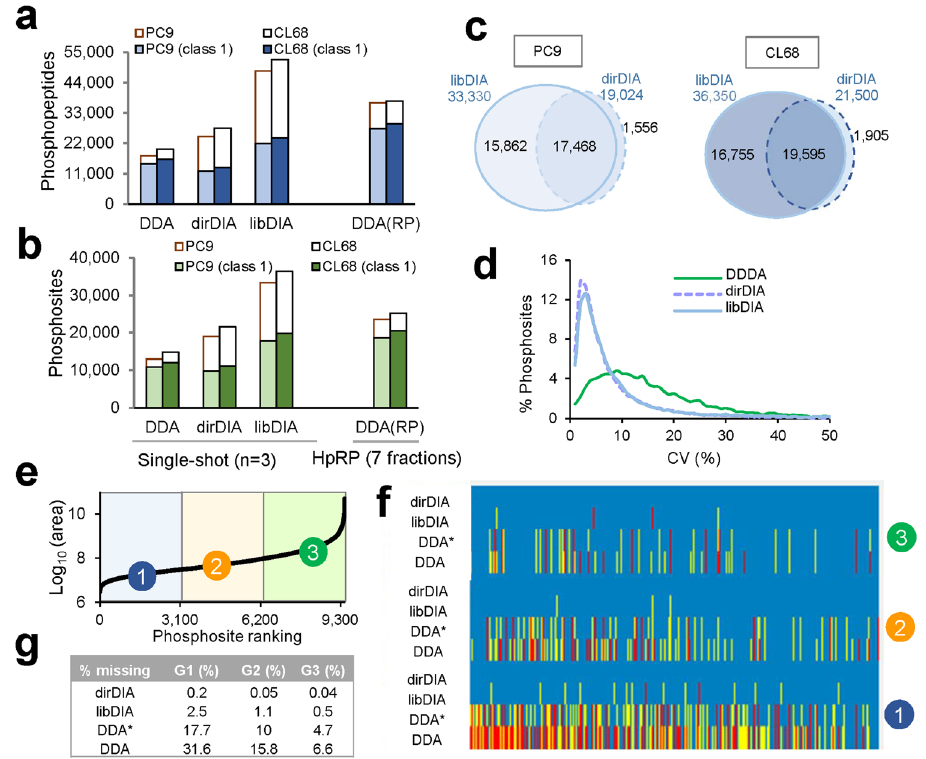
Fig. 4 Comparison of quanti fi cation performance in DDA and DIA using cell lysate. Two NSCLC cell lysate of PC9 and CL68 were processed by both DDA and DIA mode including reverse-phase (RP) fractionation. The DDA data were searched by MaxQuant, whereas DIA was analyzed by Spectronaut in both library-based and direct DIA mode. a Summary of phosphopeptides identi fi ed by single-shot DDA, StageTip fractionated DDA (7 fractions run in duplicate), library-based DIA (libDIA), and direct DIA (dirDIA). b Phosphosite identi fi cation comparison. The single-shot DDA and DIA were acquired in triplicate. c Overlap of phosphosites between dirDIA and libDIA. d Distribution coef fi cient of variation, CV% of phosphosites of PC9 cell ( n = 9,665 for DDA, 19,007 for dirDIA, and 30,260 for libDIA. A median coef fi cient of variation (CV) value of 13.0%, 4.3%, and 5.2% were obtained for DDA, dirDIA, and libDIA in PC9, respectively. e Distribution of phosphosite abundance rank of commonly quanti fi ed 9456 phosphosites in DDA, DDA match between runs (represented as DDA*), libDIA, and dirDIA. f Phosphosites identi fi cation per each abundance group across triplicate measurements. The blue, yellow, and red lines represent sites quanti fi ed in all the three, two, or only in one replicate, respectively. g Missing values across different abundance groups. Source data are provided as a Source Data fi